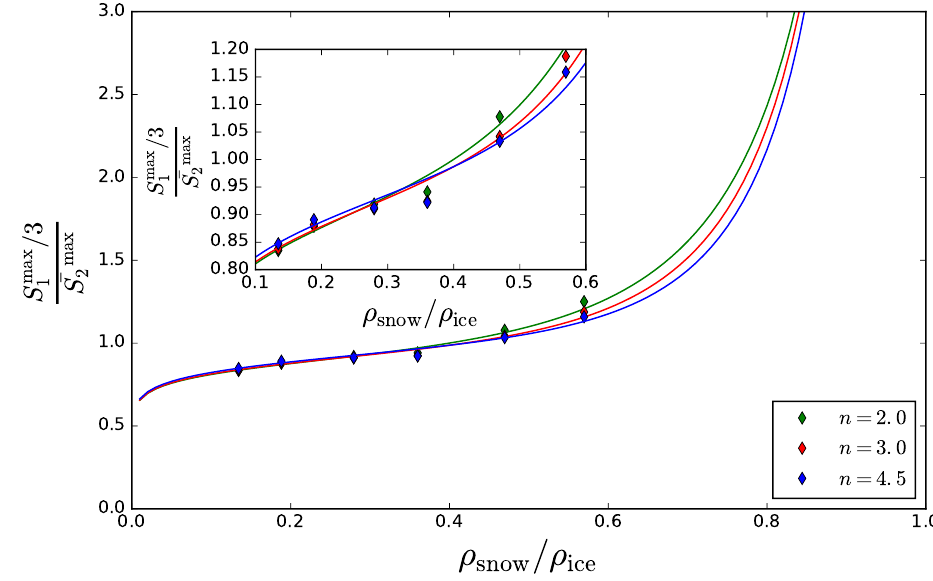
Figure 8. Aspect ratios (S max 1 / 3 )/S 2max of the Abouaf models with respect to snow relative density. Numerical results are represented with diamond points, results computed using functions (Eq. 29) with solid